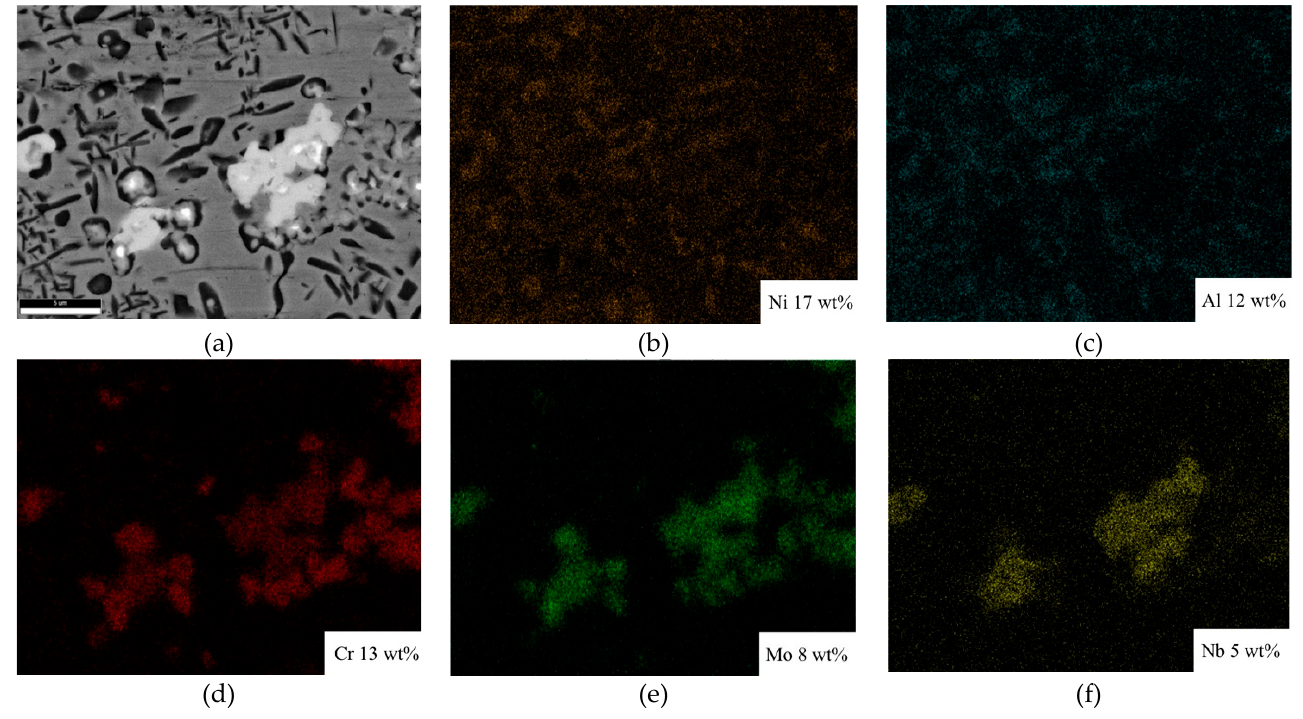
Figure 5. Chemical element distribution maps of a 25%Ni sample showing the main types of parti- cles formed in the 3D-printing process of the bronze/Inconel multimaterial: ( a )—SEM image, ( b – f )—chemical element